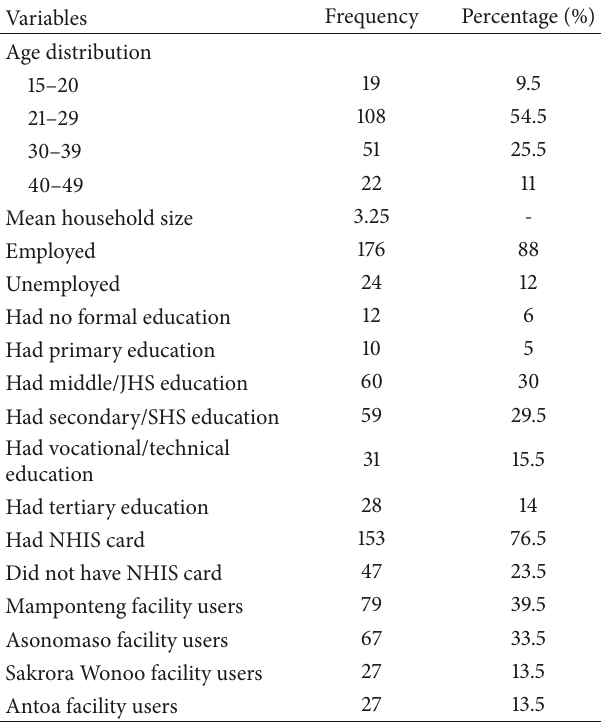
Table 2: Socioeconomic characteristics of respondents on ANC